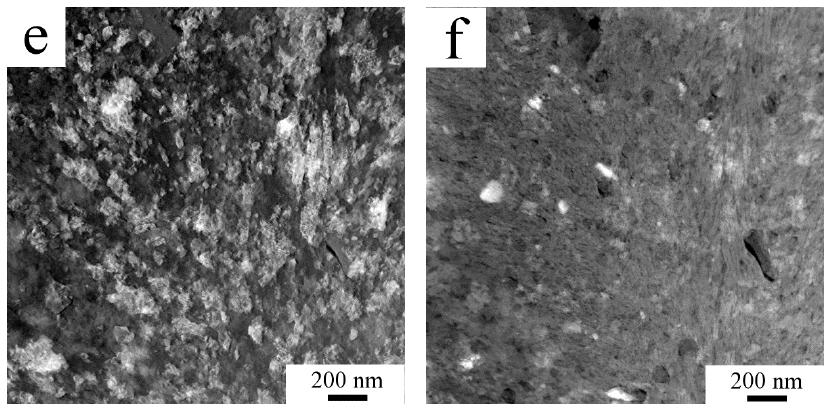
Figure 1. The morphology and microstructure of the AlZrTi powder: the gas atomized powder particles ( a ), milled powder particles showing a wide variety of powder particle size ( b ) and cross section of milled powder particles showing regions with higher atomic number elements ( c ), SEM. The fine grained structure of milled powder particle as revealed by TEM ( d ) and scanning transmission electron microscopy (STEM; e , f ).